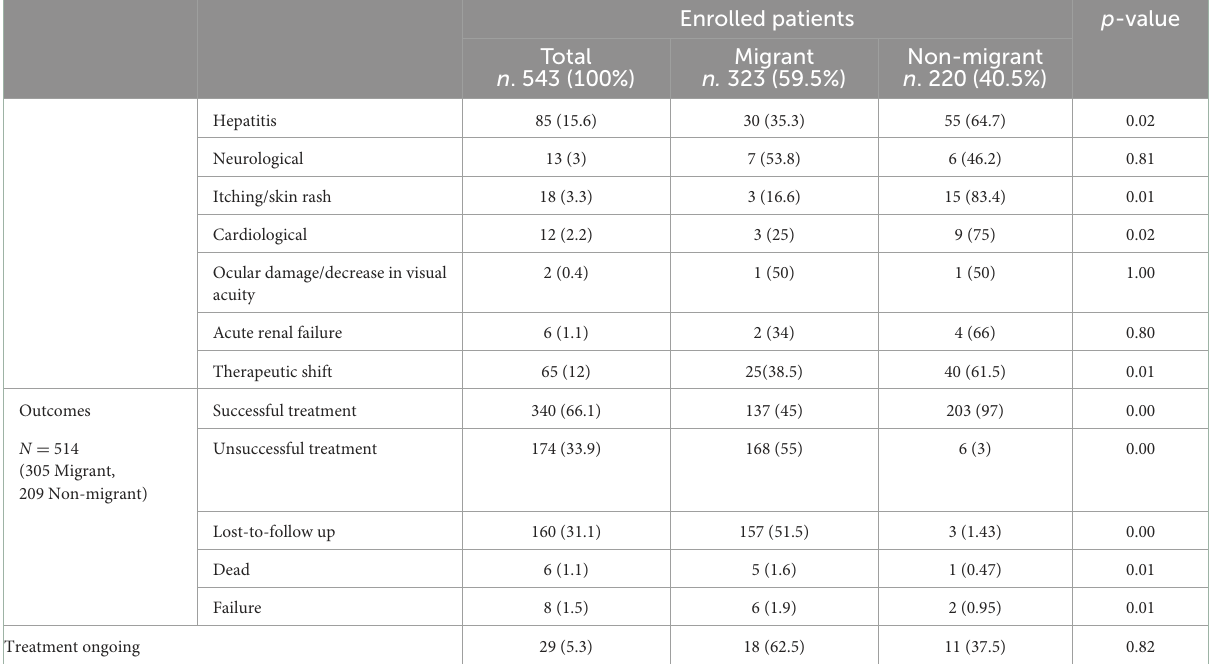
The multivariate logistic model on the adverse events considered the effects of migrant status, age > 65, gender, homelessness, presence of respiratory symptoms, diagnostic delay and length of hospitalization, drug resistance, treatment regimen and TB culture positivity, TB localization (lung or extrapulmonary). In fact, age > 65 years (O.R. = 3.11; 95%